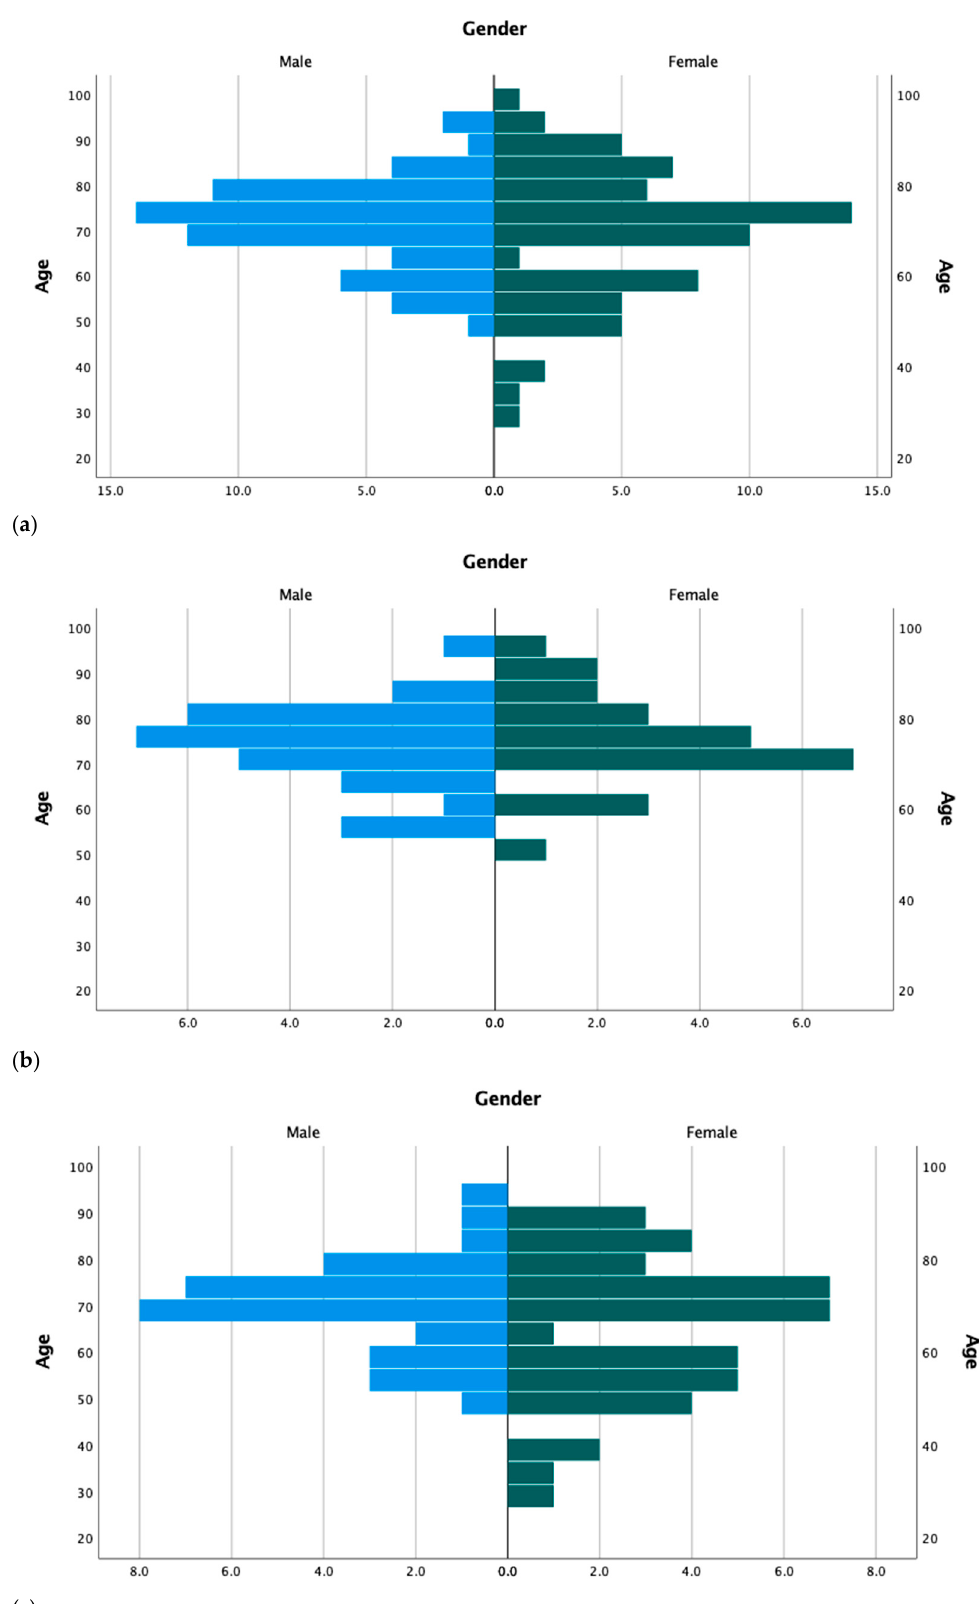
Figure 1. Distribution of patients by age groups and gender for the whole population ( a ), first ( b ), and second ( c ) pandemic waves.